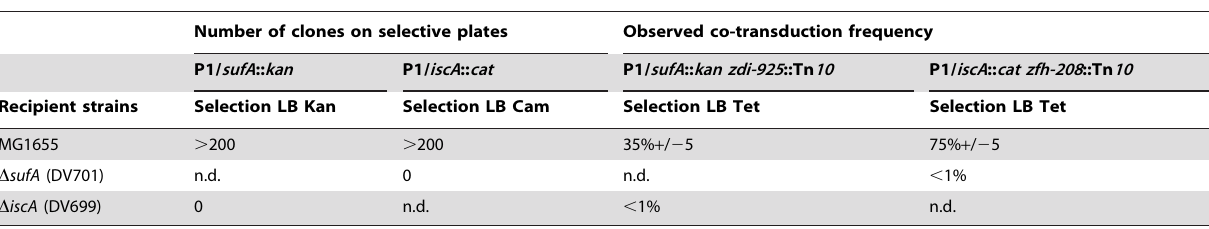
Table 1. iscA and sufA mutations are synthetically lethal in the presence of oxygen.